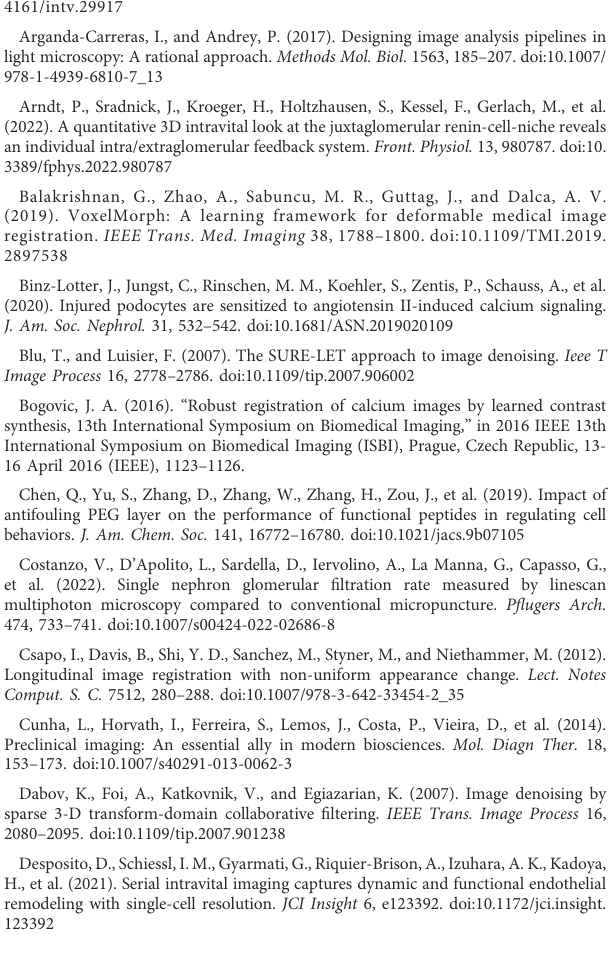
SUPPLEMENTARY FIGURE S2 Landmark-based 3D registration of serial intravital microscopy data using BigWarp. (A) : Representative 2D images of volumetric serial intravital 2- photon microscopy data acquired in a control Cdh5-Confetti mouse kidney at day 1, and day 7 with and without 3D registration with BigWarp. Endothelial cells expressing the Brainbow2.1 reporter system can be identi fi ed through 10 different color combinations (Table 1). Note relatively stable tissue orientation over time. Small misalignments between day 1 and day 7 are compensated for through 3D registration (arrowheads). Scale bars = 50 µm. (B) : Principle of BigWarp